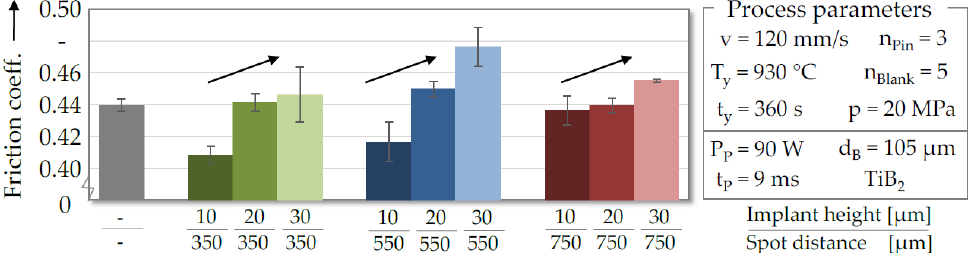
Figure 12. Quantified friction coefficients by using unmodified and laser-implanted tools.